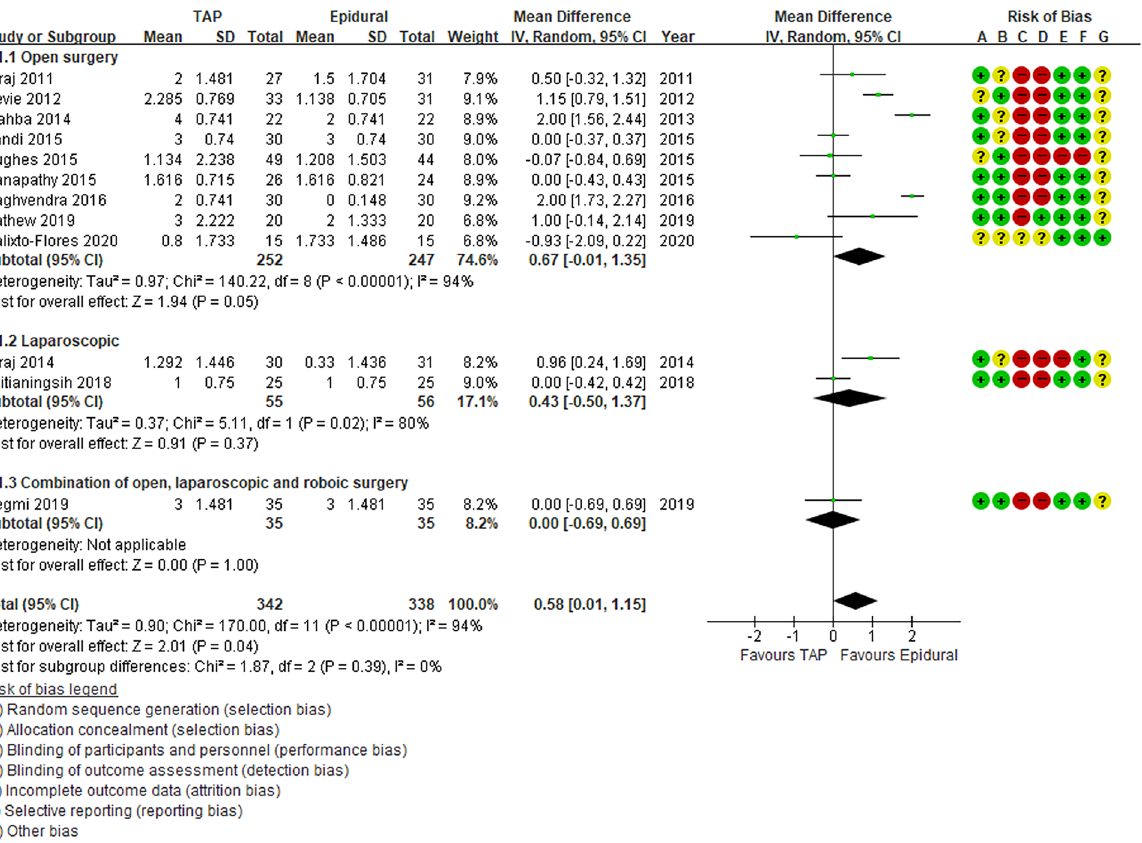
Figure 3. Forest plot of comparison: Pain score at rest at 12 h after